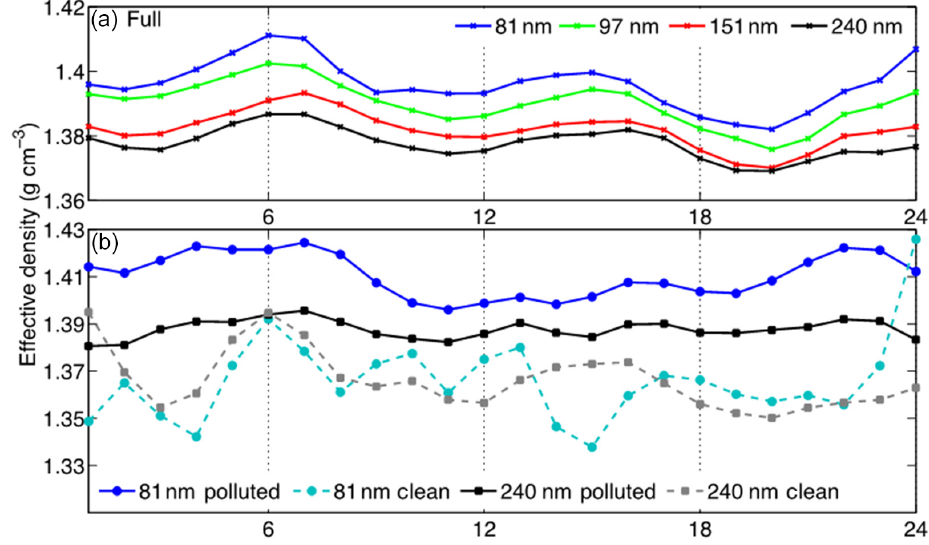
Figure 4. (a) The diurnal variation of the effective density (gcm − 3 ) of the four particle sizes from the full observational period. (b) The effective density (gcm − 3 ) diurnal cycle of the 81 nm (blue circles) and 240 nm (black squares) particles during the clean (dashed, lighter colors) and polluted (solid, darker colors) periods.